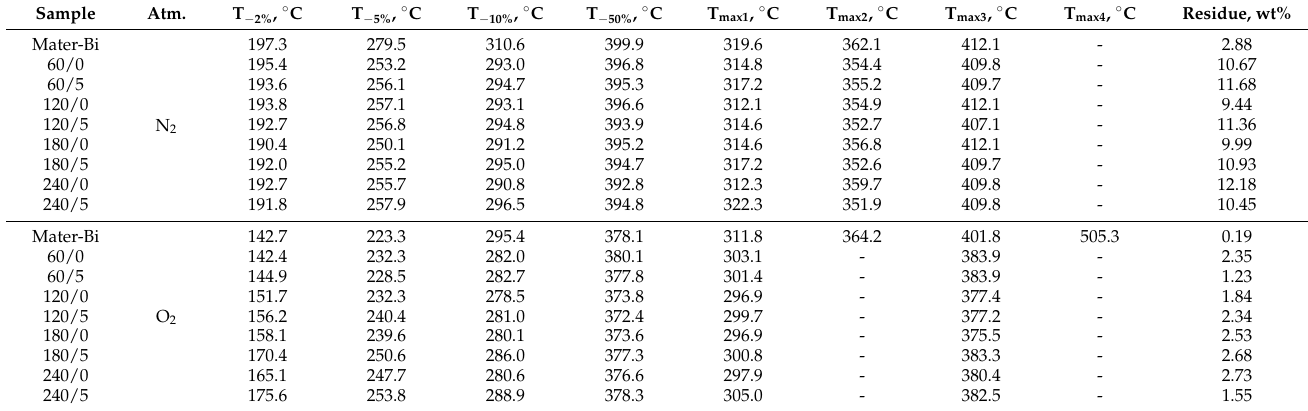
Table 5. Results of thermogravimetric analysis of prepared